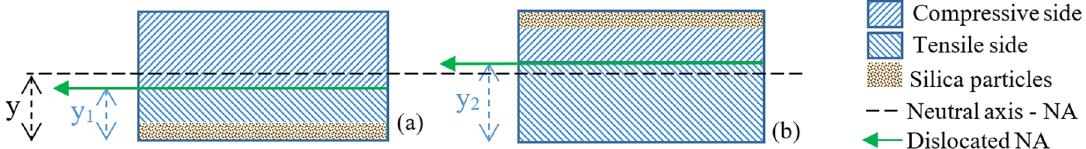
Figure 5. Scheme to illustrate the effect of silica particles on the neutral axis of unbalanced mass laminates with particles placed on the bottom side (a) and on the top side (b).